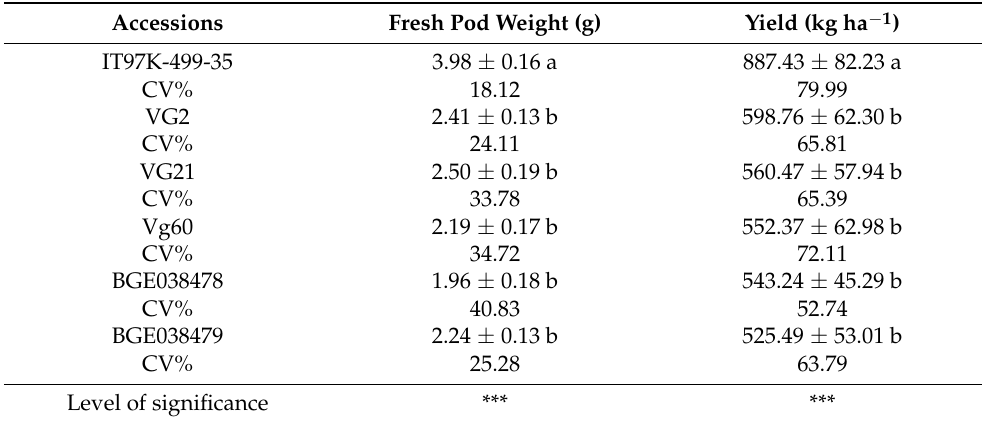
Table 3. Yield and yield related trait studied for each accession and coefficients of variation (CV%) for each accession and trait. Means ± SE in columns with different letters are significantly different at the 0.05 level, by Tukey’s HSD means comparison